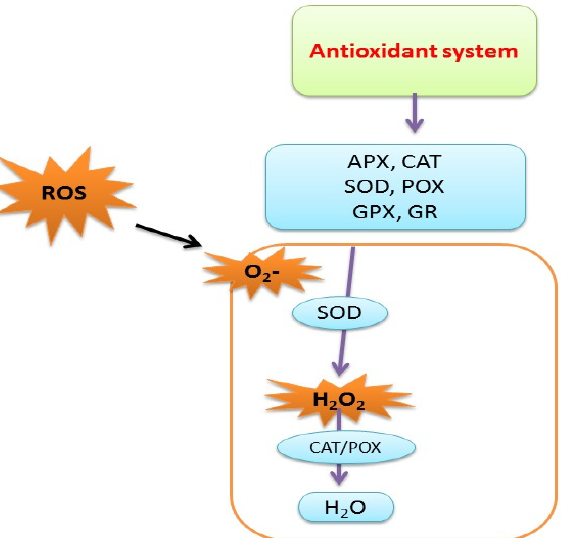
Figure 7. Simple illustration of detoxification of ROS through antioxidants. A plant cell has various antioxidant enzymes which detoxify the ROS. They work in a series. For instance, O 2 − is scavenged by SOD, which converts O 2 − into H 2 O 2 , whereas CAT converts H 2 O 2 into H 2 O and O 2 .